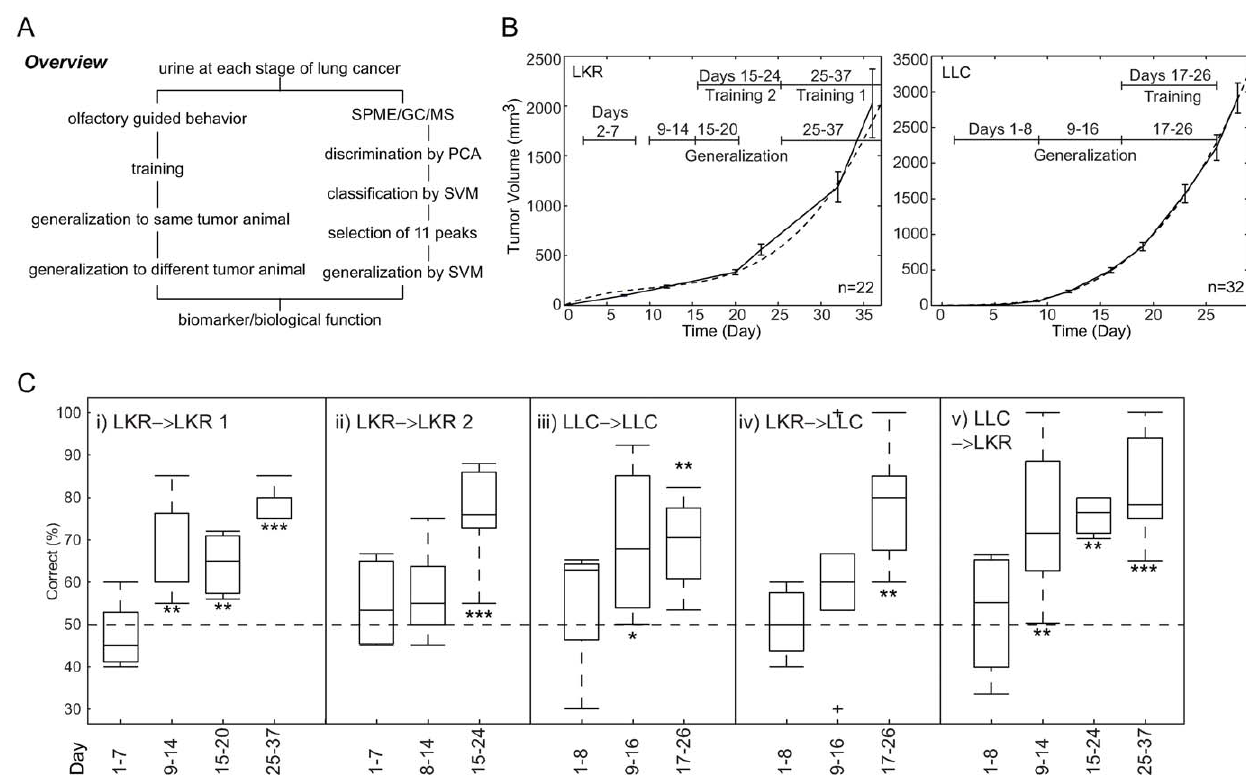
Figure 1. Tumor growth curves and urine collection times for bioassays and the results of bioassay. (A) Overview of experimental procedure. We employed mouse olfactory guided behavior (left) and metabolomic (right) approaches. (B) LKR cells and LLC cells were injected subcutaneously into the flanks of adult male mice and tumor size was measured weekly thereafter. Each time point shows the mean 6 SEM tumor size. Solid line: actual data; Dotted line: curve fitted with cubic function; LKR: y=0.092*x 3 2 2.8*x 2 + 38*x 2 18, LLC: y=0.16*x 3 2 0.83*x 2 + 3.5*x 2 4. Mouse urine was collected individually once a day and was used for chemical analysis and for bioassay during the periods indicated: For LKR - Days 15 2 24 and 25 2 37 for training and Days 2 2 7, 9 2 14, 15 2 20, and 25 2 37 for generalization; For LLC - Days 17 2 26 for training and Days 1 2 8, 9 2 16, and 17 2 26 for generalization. (C) Box plot of generalization scores for bioassay and the correlations among tests. Blue boxes represent the lower and upper quartiles. The red horizontal bar in each box indicates the median. The dotted line represents the range of observations. The plus ( + ) marks extreme outlier observations. *; P , 0.01, **; P , 0.001, ***; P , 0.0001 compared to the null hypothesis of a 50% generalization score. From left, LKR- trained mouse urine generalization to LKR mouse urine (Training 1, Figure 1C-i); LKR- trained mouse urine generalization to LKR mouse urine (Training 2, Figure 1C-ii); LLC-trained mouse urine generalization to LLC mouse urine (Figure 1C-iii); LKR-trained mouse urine generalization to LLC mouse urine (Figure 1C-iv); LLC-trained mouse urine generalization to LKR mouse urine (Figure